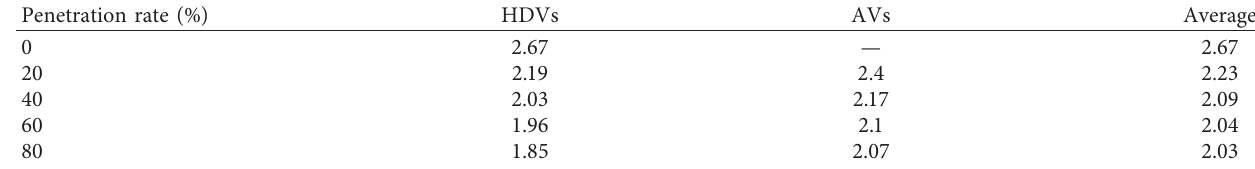
Table 3: Stop frequency at intersection by AV